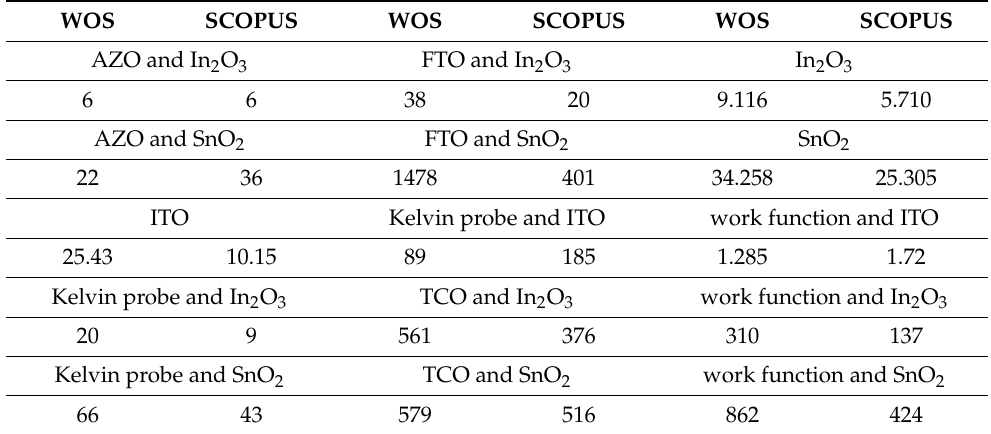
Table 3. List of published publications according to two databases, taking into account specific issues